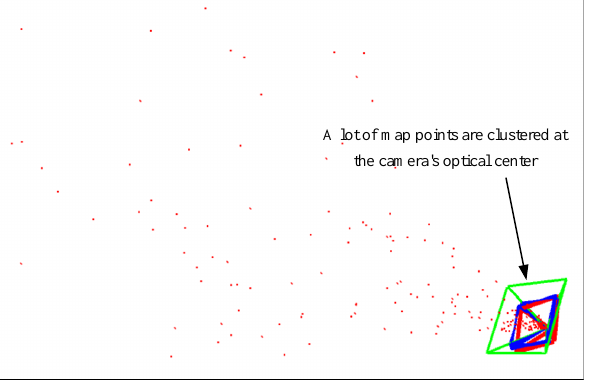
Figure 2. Some map points are generated at error coordinates by